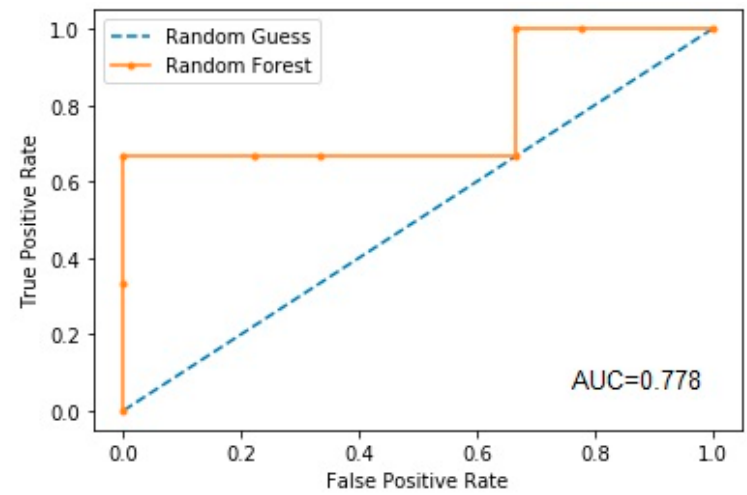
Figure 4. Area under the ROC curve for the prediction of functional decline.